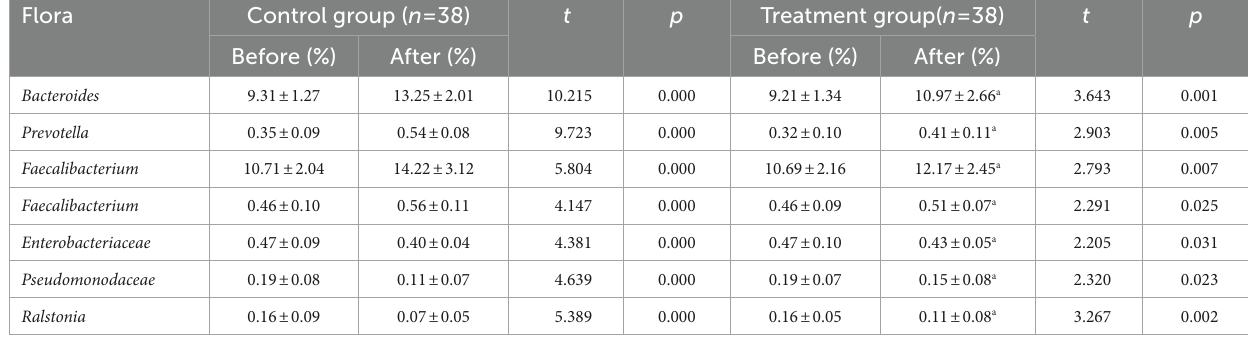
TABLE 2 The data before and after the TMS treatment of the different studied variables (Stool metabolites). N Acetic